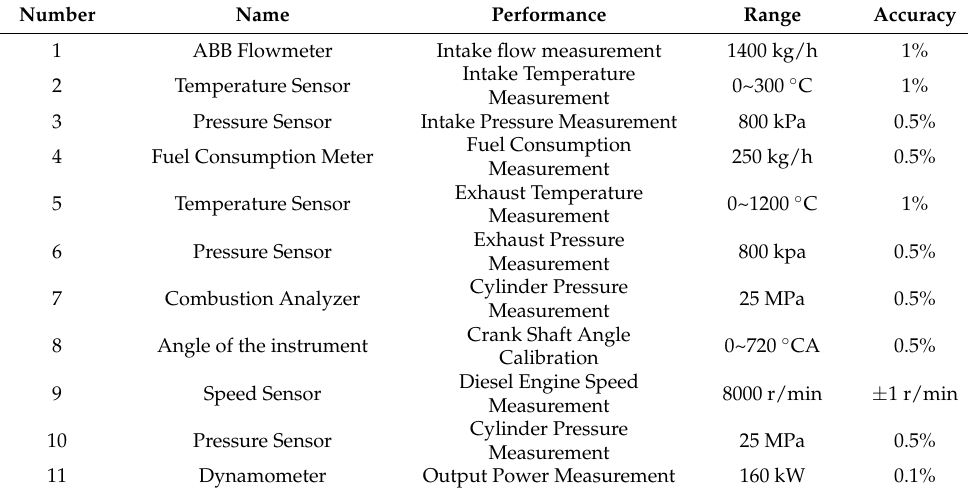
Table 3. Range and accuracy of sensor on the test bench.